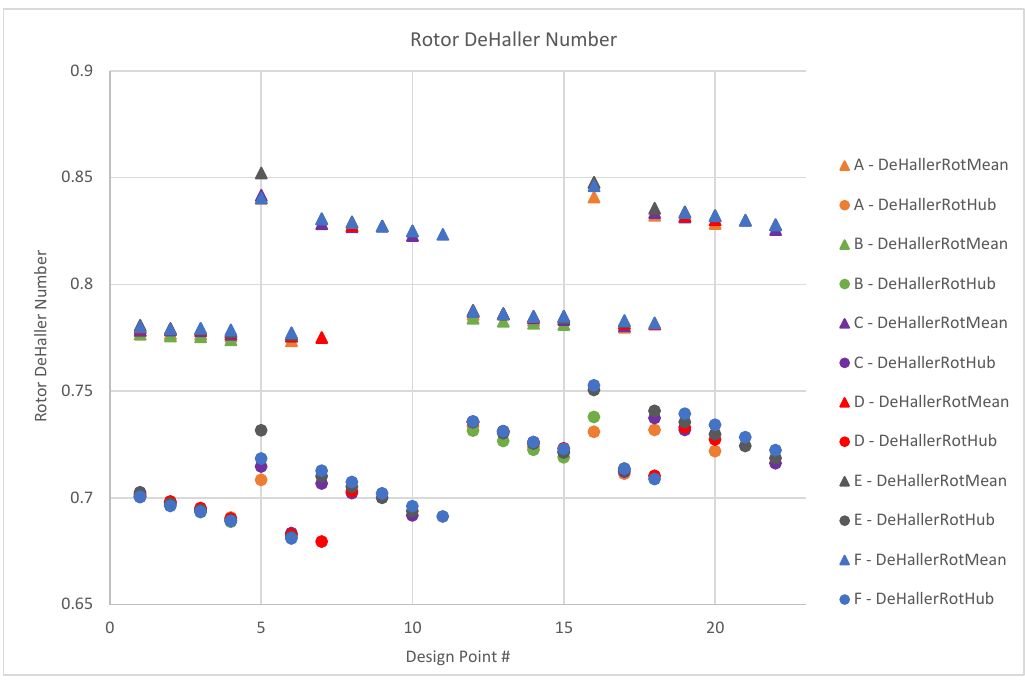
Figure 18. Variations in the rotor loading coefficient with the different rotor blade parameters.